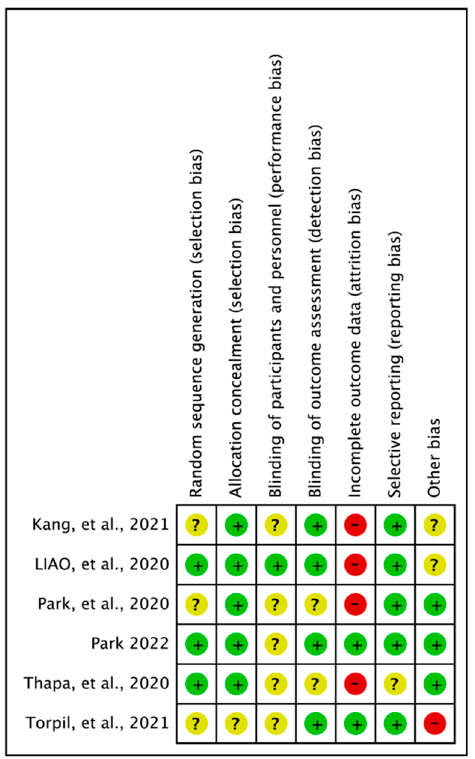
Figure 2. Risk of bias summary: review of authors’ judgments about each item for each included study. Kang et al., 2021 [24] , Liao et al., 2020 [25] , Park 2022 [26] , Park et al., 2020 [27] , Thapa et al., 2020 [28] , Torpil et al., 2021 [29] .